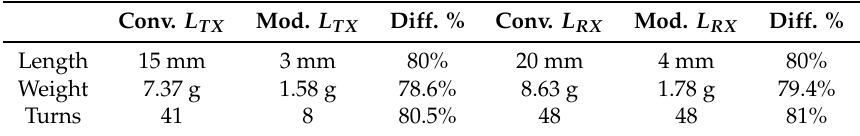
Figure 15. Comparison between measured and calculated maximum distances between the T X and R X coil between the system with high Q coils and the system with added inductor. The results show a similar distance of transmission that can be achieved with both systems. Table 4. Comparison of the physical parameters of the conventional and modified systems. Proposed system shows a great improvement towards the conventional